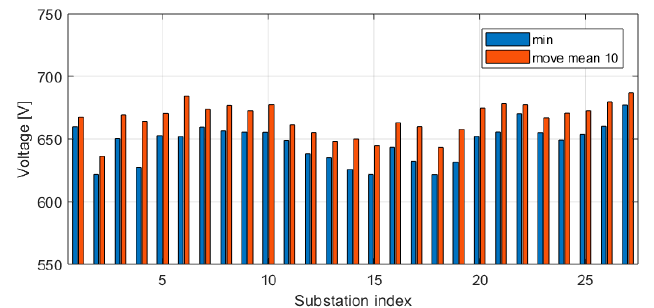
Figure 14. Voltage of substations.